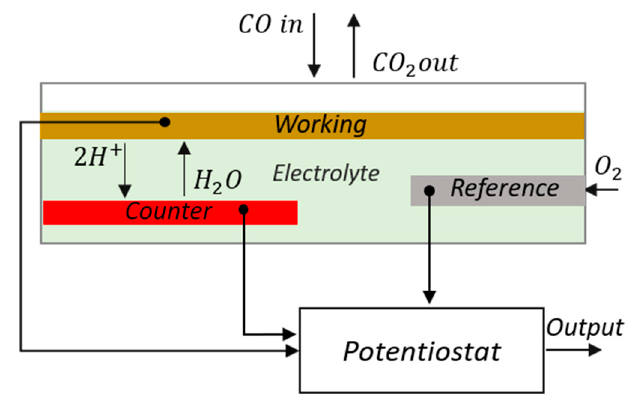
Figure 6. Nemoto NAP-505 three electrode CO sensing element.